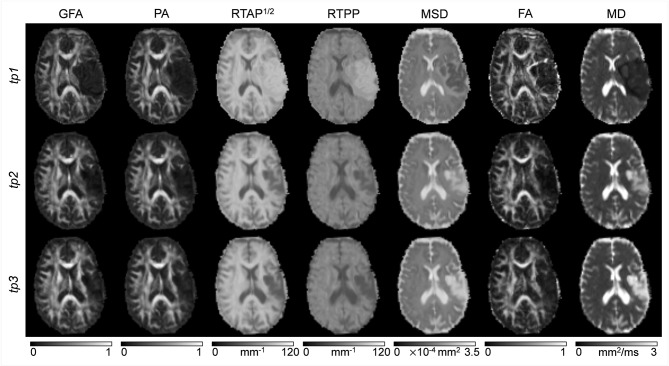
dMRI-based indices on a representative patient. Axial slices of a representative patient (ischemic stroke in left cortico-subcortical areas) are reported for each index (columns) and each time point (rows). Images are displayed in radiological convention.